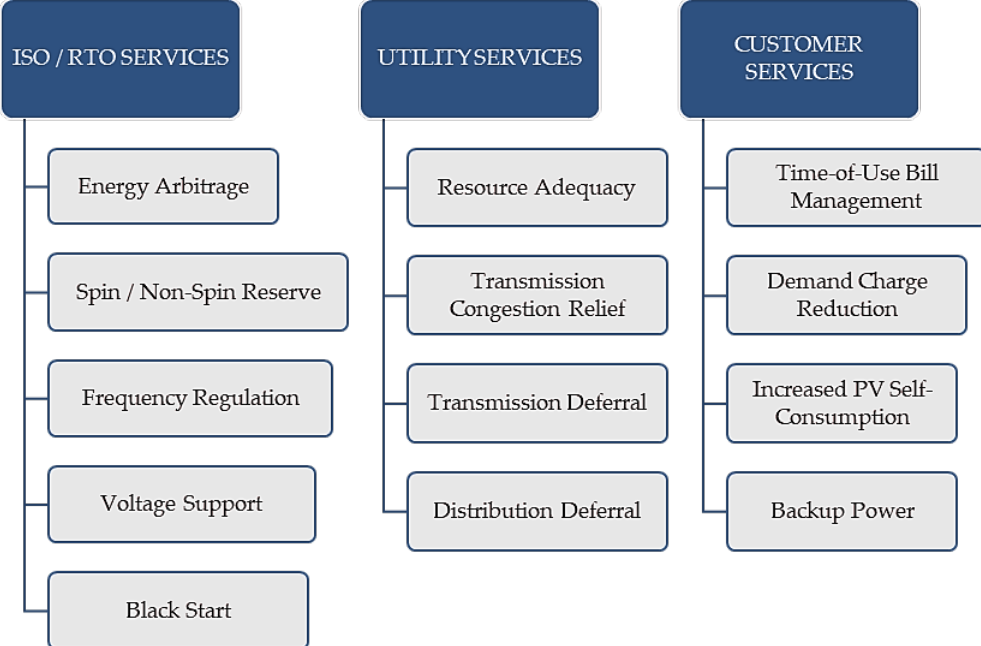
Figure 3. Battery energy storage value chain based on [76,77].